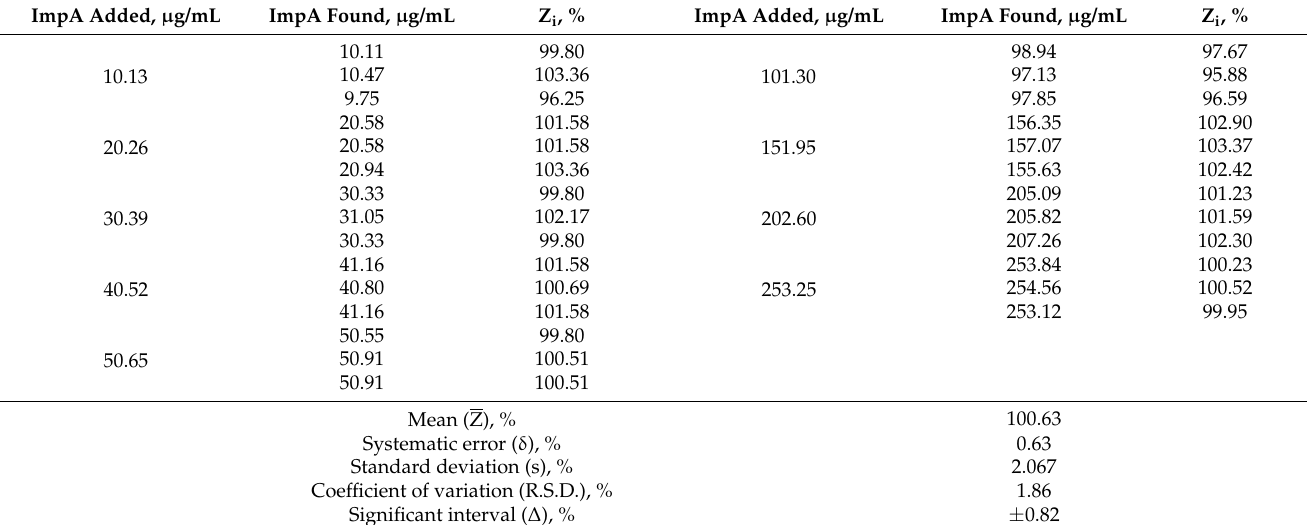
Table 3. Results of the Accuracy Studies of the